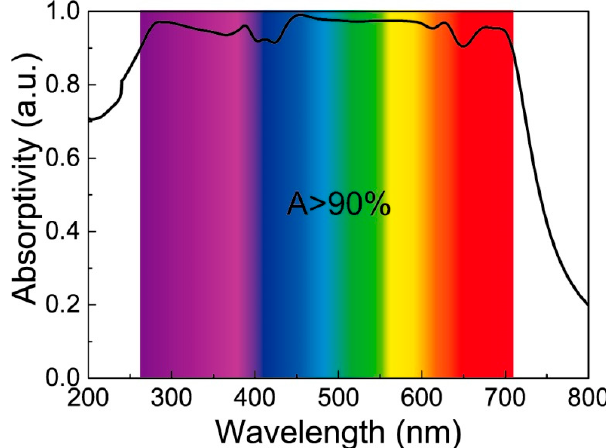
Figure 2. Simulation results of the proposed DBMPA, the black solid line represents the absorptivity from 200 nm to 800 nm, and the rainbow indicates that the absorption is greater than 90% of the wavelength corresponding to the wavelength color from 262 nm to 709 nm.